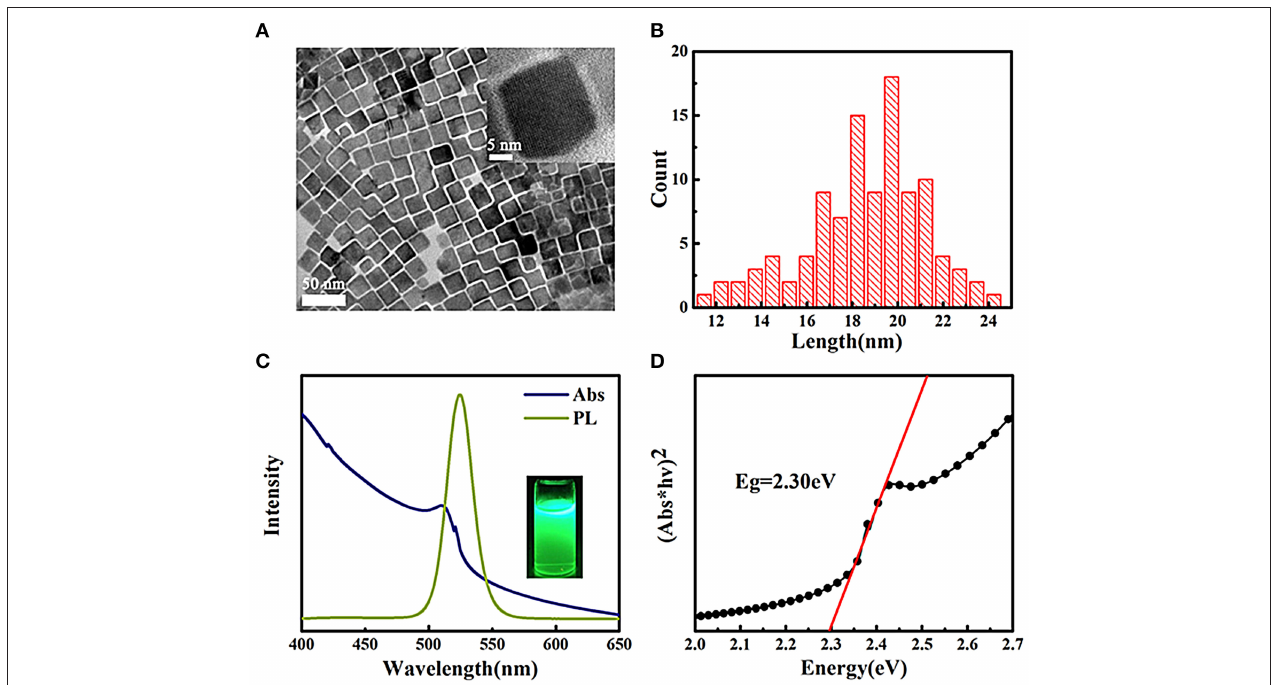
FIGURE 1 | (A) TEM images of CsPbBr 3 NCs, the inset is HRTEM images, (B) size distribution histogram, 100 particles were counted. (C) Optical absorption and PL spectra of CsPbBr 3 NCs solution, the inset is the photograph of NCs solution under UV excitation. (D) Tauc plot curve obtained from optical absorbance